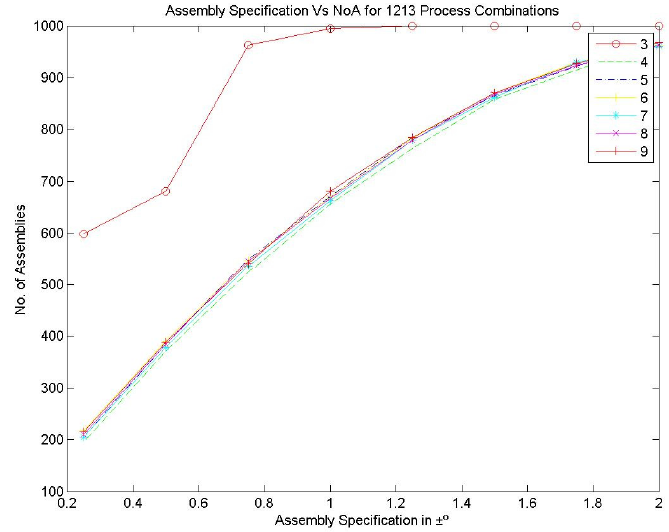
Figure 7. Assembly specification vs. NoA for various bin numbers—the 3213 process combination.